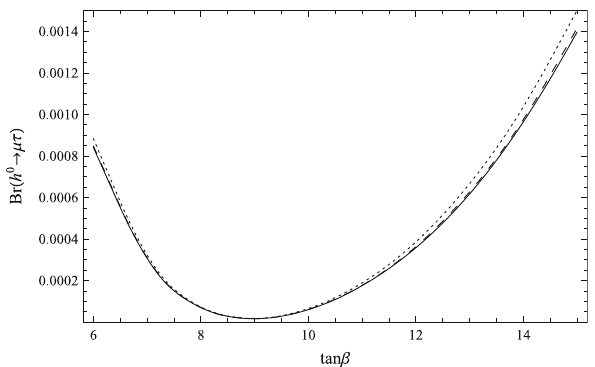
Fig. 20 With Al = 0 . 5 ( 1 , 1 . 5 ) TeV, the branching ratios of h 0 → e μ versus parameter A (cid:2) l are plotted by the dotted (dashed, solid) line